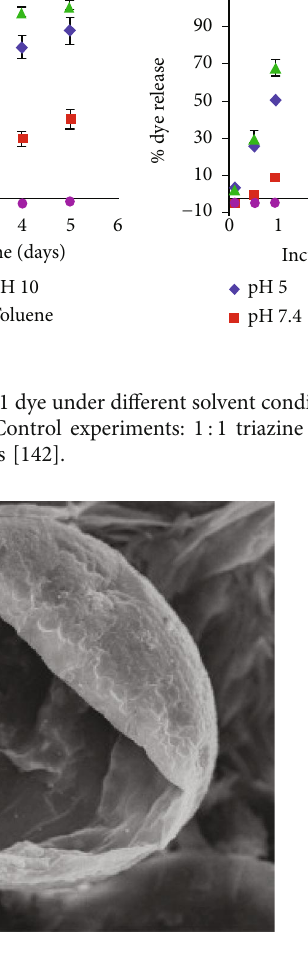
Figure 49: SEM micrograph of a fractured microcapsule having β - carotene as a core [143].